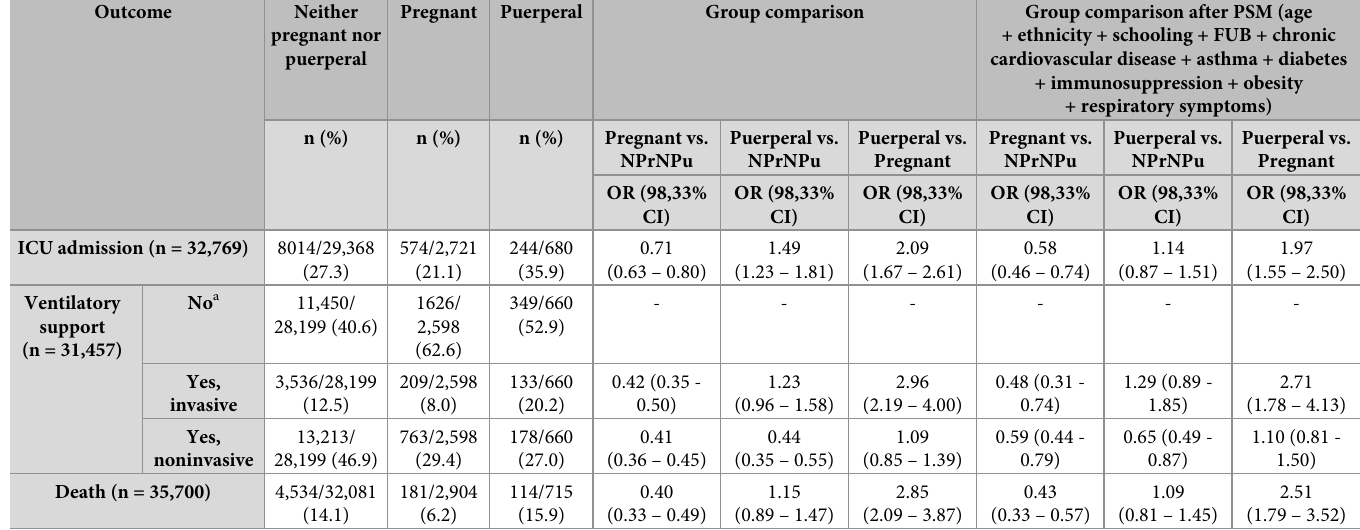
Table 3. Comparison of outcomes in pregnant, puerperal, and neither pregnant nor puerperal reproductive age women before and after propensity score matching – Brazil, February 17, 2020 – January 02, 2021.